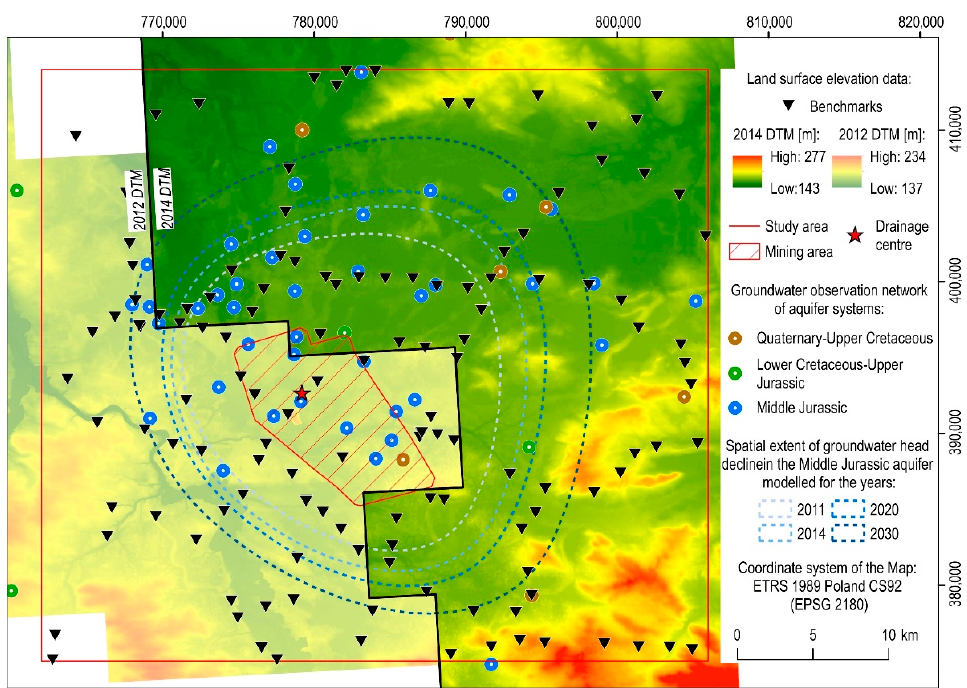
Figure 5. The spatial distribution of benchmarks of Poland’s geodetic network measured with precise levelling in 1959 and 1981, as well as with precise levelling and GNSS in 2011; DTM retrieved from ALS conducted under the ISOK project in 2012 and 2014 represented by lighter and darker green-yellow-red color scheme, respectively; and piezometers in the Quaternary-Upper Cretaceous, Lower Cretaceous-Upper Jurassic and Middle Jurassic aquifers. Source of data: the Main Office of Geodesy and Cartography of Poland and Polish Geological Institute-National Research Institute.